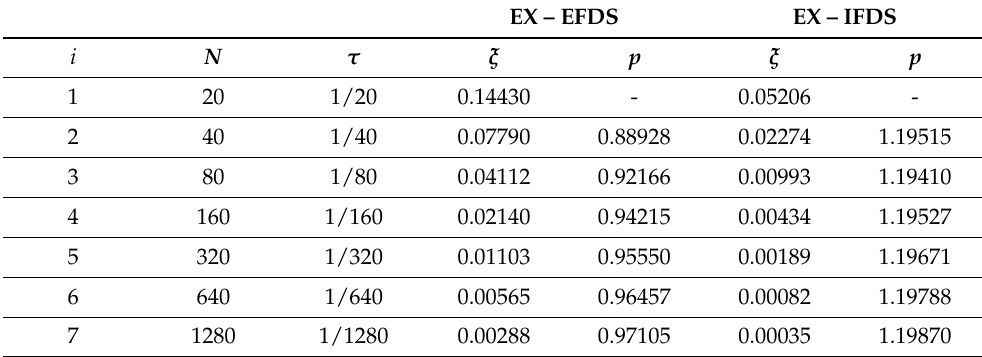
Table 2. Computational precision: accurate solution EX, EFDS and IFDS, at T = 1.